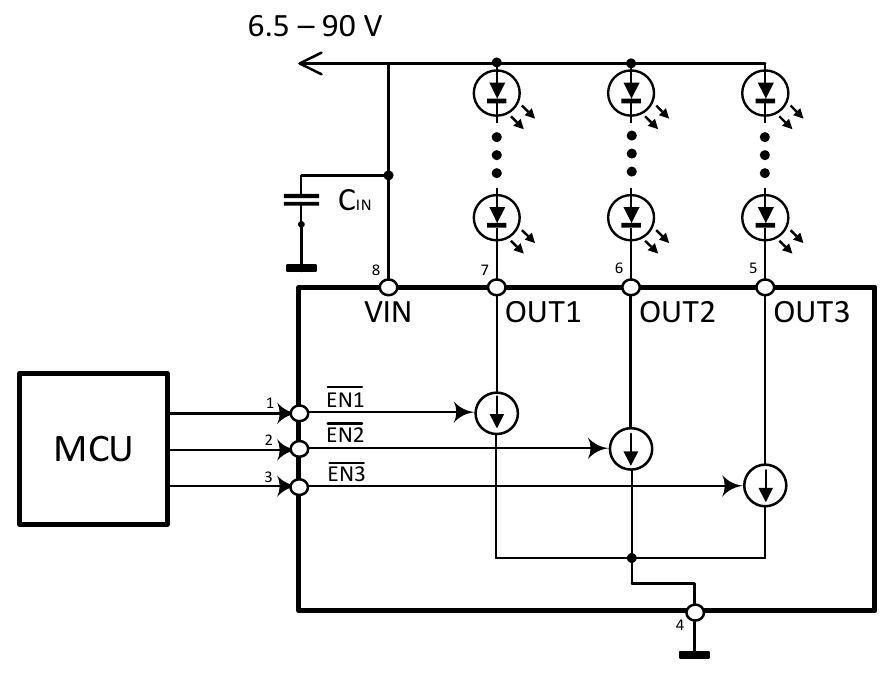
Figure 7. Wiring diagram of LED driver, CL320, adapted from [30].